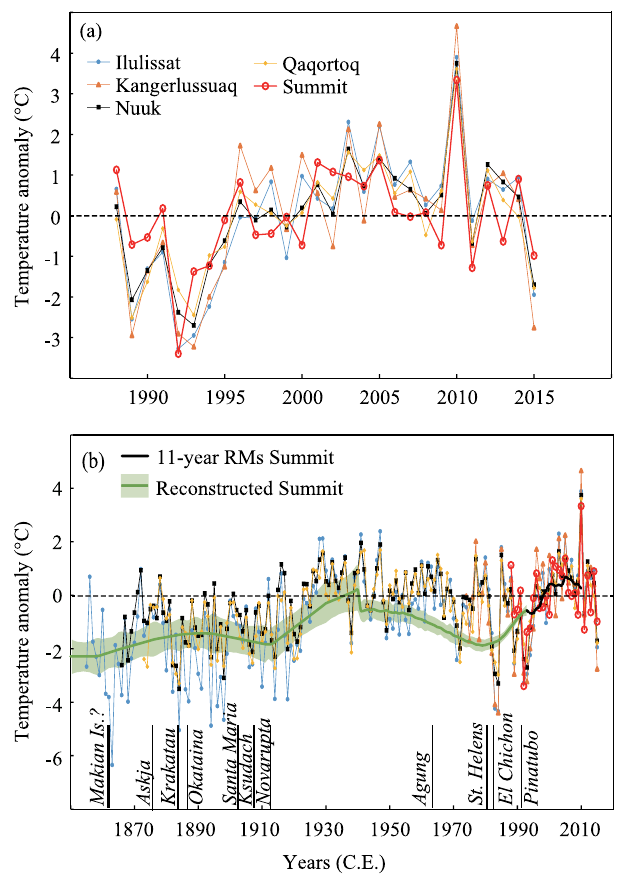
Figure 1. Greenland temperature anomalies relative to averages of 1988–2015 at the Summit and four coastal stations. ( a ) Temperature anomalies from 1988 to 2015. ( b ) Same as ( a ) but from 1850 to 2015. Green line with 2 σ error bands is the reconstructed temperature anomaly. The reconstructed temperature (snow temperature) was adjusted to have the same value in 1993 as an average of the observed Summit temperature (air temperature) for 1988–1998 by adding 1.0 °C. The names and timings of large volcanic eruptions are according to Box et al . 13 . RMs represents running